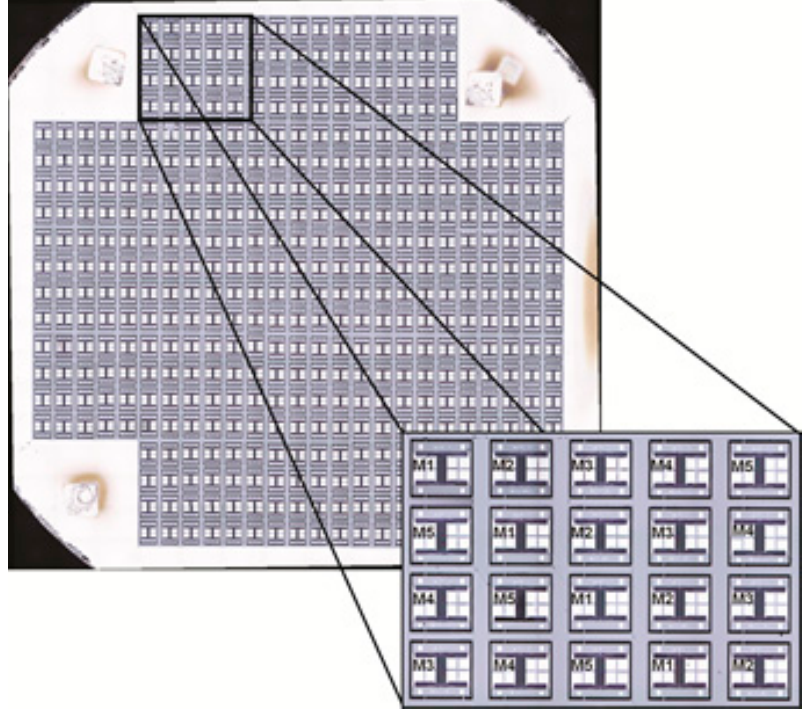
Figure 13. A 200 mm processed silicon-on-insulator (SOI) wafer with 21 reticules (420 DUT). Each reticule contains 20 MEMS devices (five different configurations, M1–M5).